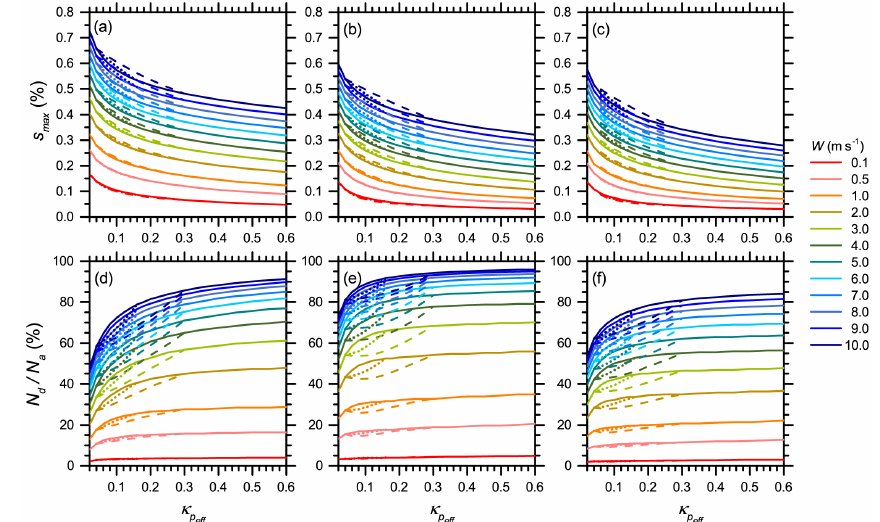
Figure 2. Maximum supersaturation reached (top) and fraction of particles activated (bottom) for the internal mixing (solid line) and external mixing cases Ext 1 (dotted line) and Ext 2 (dashed line). Plots on columns (a, d) , (b, e) and (c, e) are for MP 5 , 1 , MP 1 , 5 and HP 5 , 5 case studies, respectively. The color scale refers to the updraft velocities from 0.1 to 10ms − 1